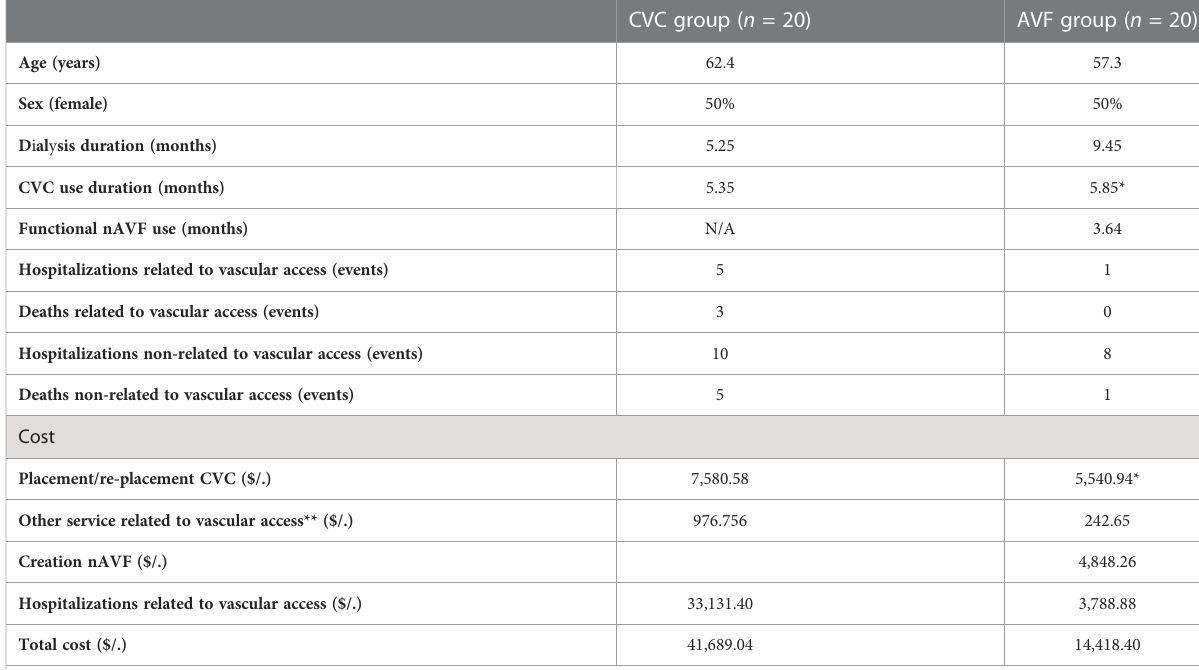
TABLE 2 Comparative costs between catheter venous central (CVC) and arterio-venous fi stula